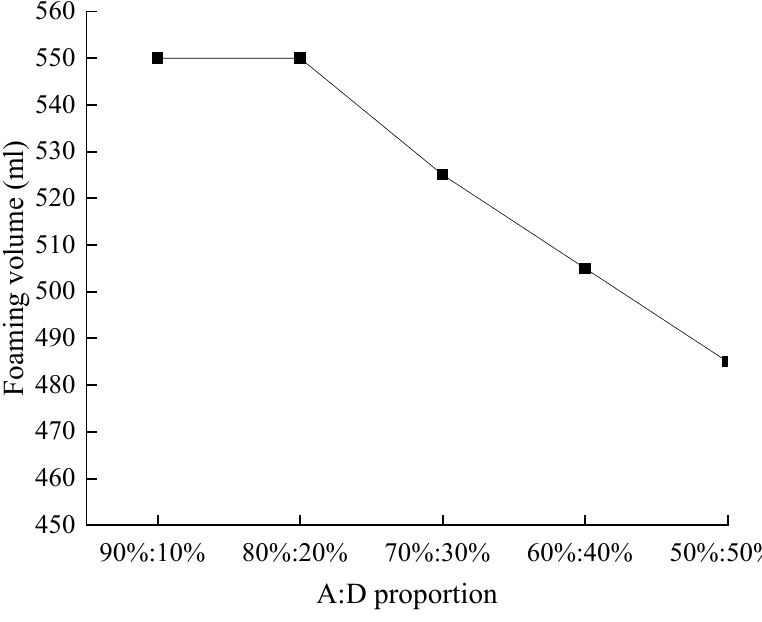
Figure 6. A/D Blister Volume